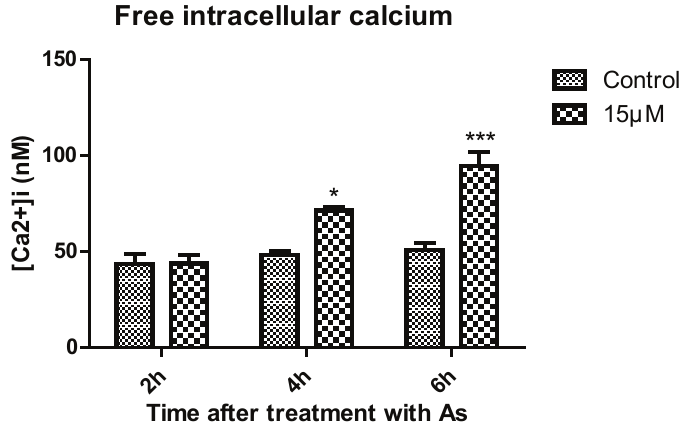
(15 µM). As causes time-dependent 50